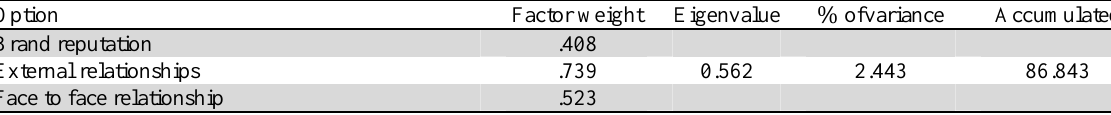
The summary of factors associated with brand relationship